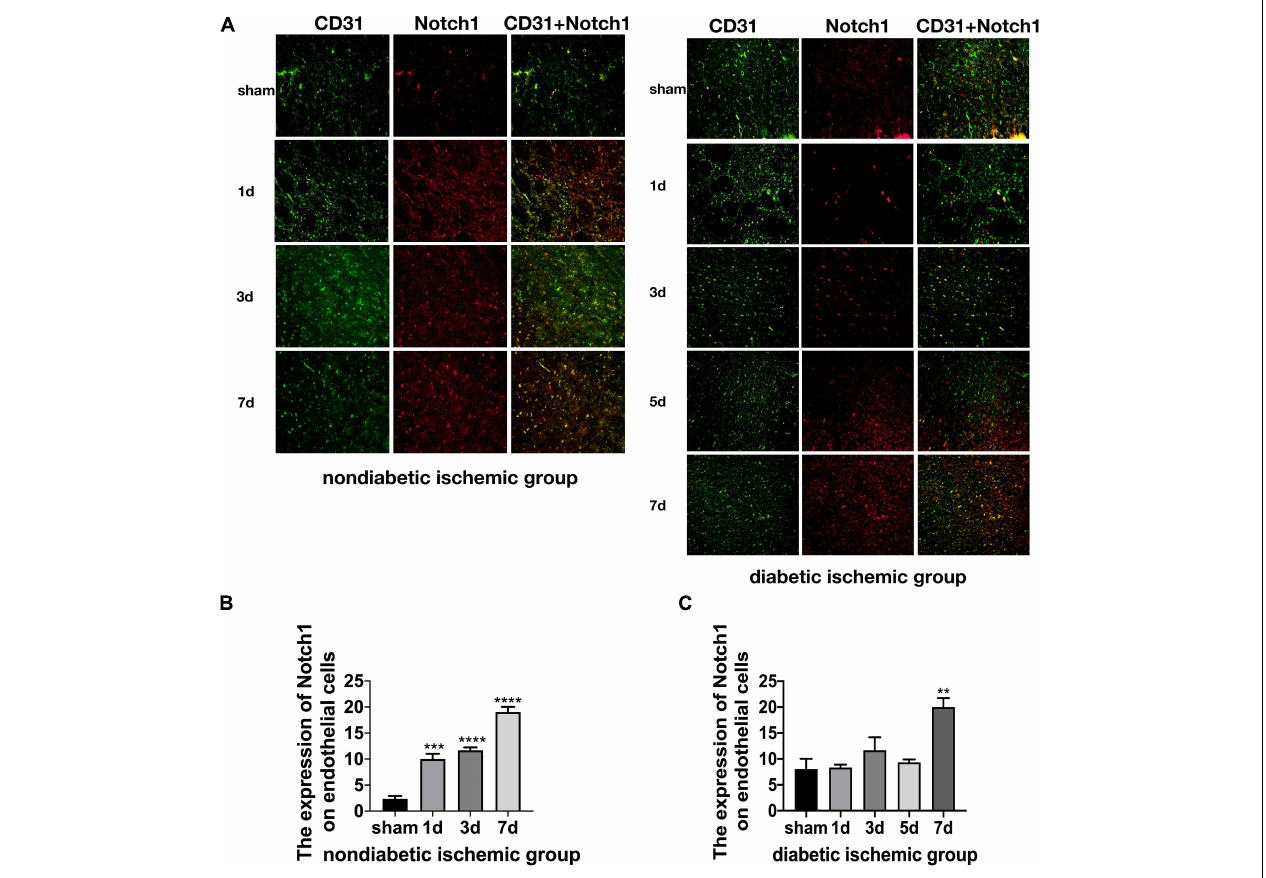
FIGURE 6 | Suppressed Jagged1-Notch1 signaling after acute ischemic stroke in T2DM. (A–C) The expression of Notch1 and CD31 was assessed by immunofluorescence staining in ischemic penumbra (Magnification × 200. Scale bar = 100 µ m) and the positive cells of Notch1 and CD31 were calculated ( n = 3 per group). ** p < 0.01 vs. sham group, *** p < 0.001 vs. sham group, **** p < 0.0001 vs. sham